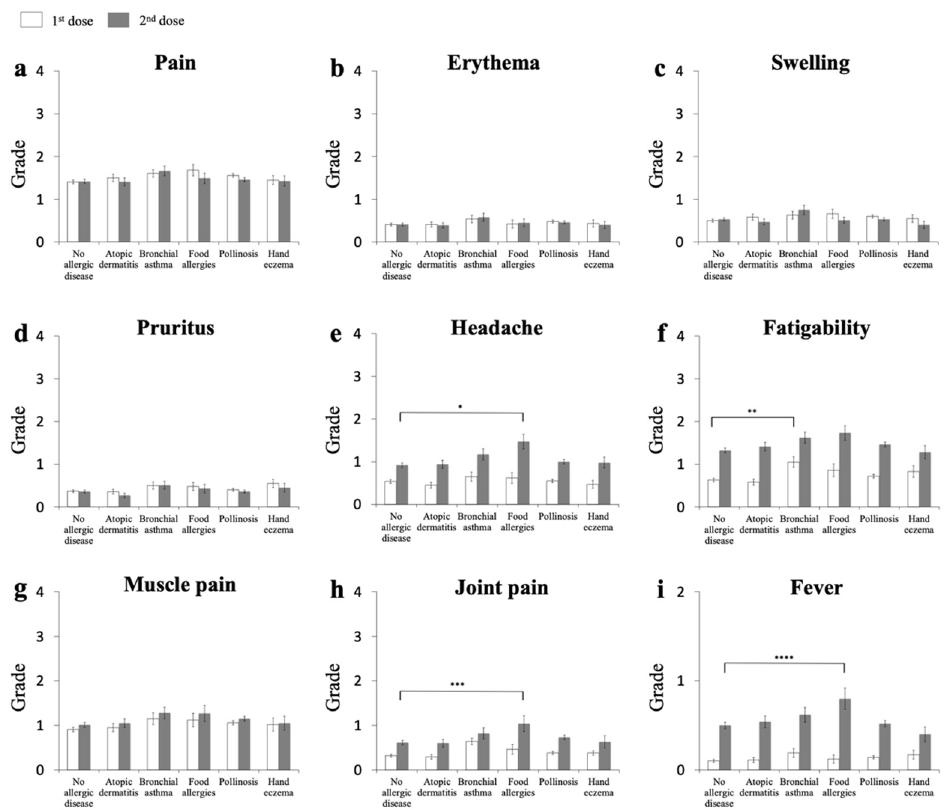
Figure 2. Local and systemic adverse reactions upon receiving first and second dose of vaccine in individuals with each of five allergic diseases and with no allergic disease. Local ( a – d ) and systemic ( e – i ) reactions are shown. Open bars represent the mean ± SE after the first dose and closed bars represent the mean ± SE after the second dose. * p = 0.0887, ** p = 0.0626, *** p = 0.338, **** p = 0.3027.